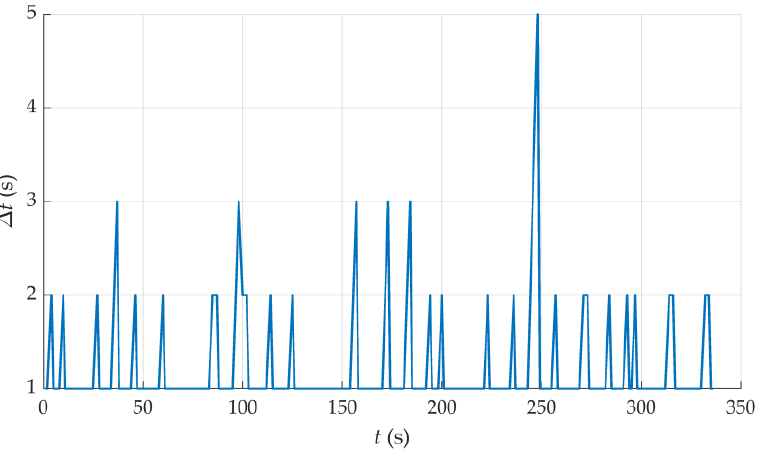
Figure 22. An example of the time intervals between successive measurements of the RSSI value obtained by the locator node LocB1 and object location PB1. Table 3. Probability of occurrence of various delays for locator nodes LocBn and all object locations PBm . Probability of